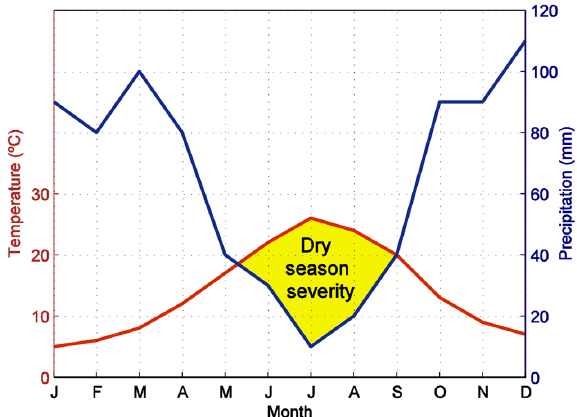
Figure 4. Definition of the dry season indicator on a climatic di- agram as the yellow patch area. On the y scales, 1 ◦ C is equiva- lent to 2mmyr − 1 of precipitation, and dry season severity (DSS) is computed as the area of the region where the temperature profile is above the precipitation profile.